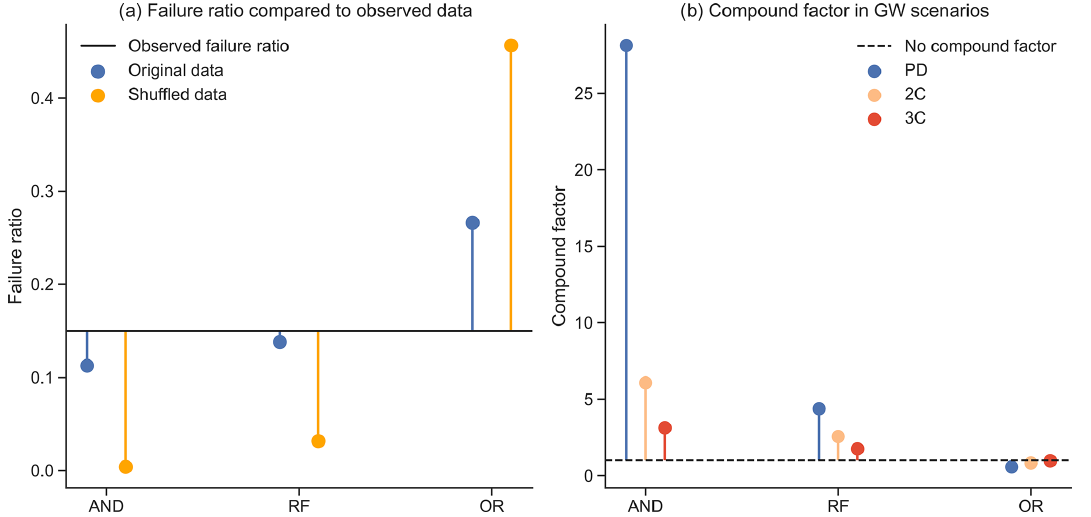
Figure 8. (a) The failure ratios for ordered and shuffled PD data for the three approaches: AND, OR and RF with respect to the failure ratio of observed data; (b) relative compound contribution level (original failure ratio divided by shuffled failure ratio) of each approach for the GW